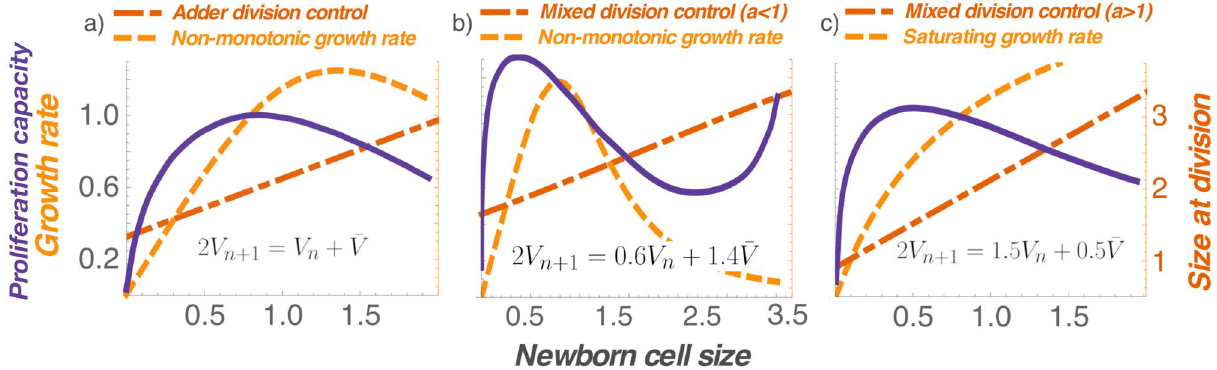
Figure 3. A non-monotonic growth rate coupled with Adder-based division control maximizes proliferation capacity at a target cell size. ( a ) A non-monotonic growth rate together with an Adder ( a = 1 ) yields a target cell size consistent with data in Fig. 1. ( b ) A non-monotonic growth rate together with an Adder-Sizer combination ( a < 1 ) results in a complex profile: a bell-shaped proliferation capacity for most physiological cell sizes, but it again increases at higher sizes. ( c ) A monotonically increasing growth rate can drive a bell-shaped proliferation capacity if a > 1 , i.e., size added in a cell-cycle duration increases with daughter cell size. Newborn cell size (x axis) is normalized by its mean. Proliferation capacity, growth rate, and size at division (y axes) are normalized by their corresponding values for the mean newborn size. The proliferation capacity for the saturating growth case is computed by solving the equations (24), (22), and (23) from the “Methods” section. For the non- monotonic growth rate case, proliferation capacity is calculated using (25), (22), and (23) from the “Methods”